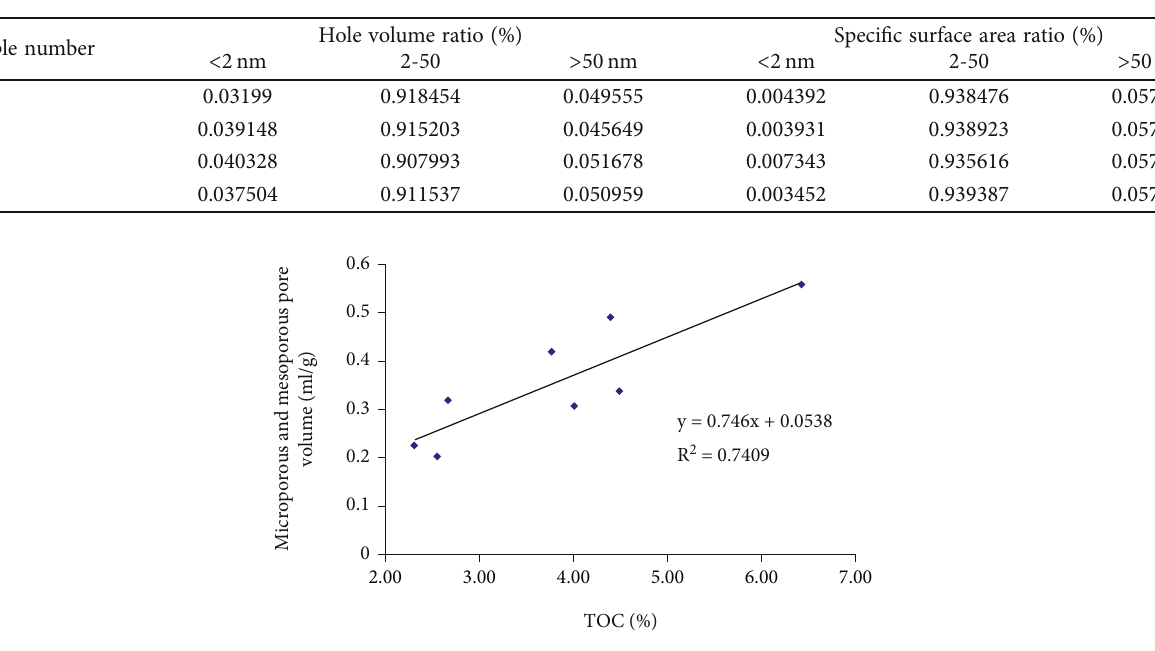
Table 4: Distribution of the surface area and the pore volume of the shale samples based on IUPAC standards.